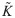
Inside manifold perturbations do not require big changes of synapse weights.(A) Synapse weights (elements of W) from one network instantiation of FORCE, compared to re-learning with the permuted encoders K˜ (elements of W˜). (B) Same as A, but for an outside-manifold permutation (W^). (C) The element-wise correlations between old (W) and new synaptic weights for different types of permutations (see main text for definitions) for all three frameworks. Error bars indicate standard deviation over 30 network instantiations. Note that orthogonal inside manifold perturbations (“Permutation” and “45 degree rotation”) require almost no changes to the weights, non-orthogonal inside manifold perturbations (“Gaussian elements” and “Same element”) require some changes and the outside-manifold permutation requires as much change as a network with unrelated encoders. See also S1D Fig.